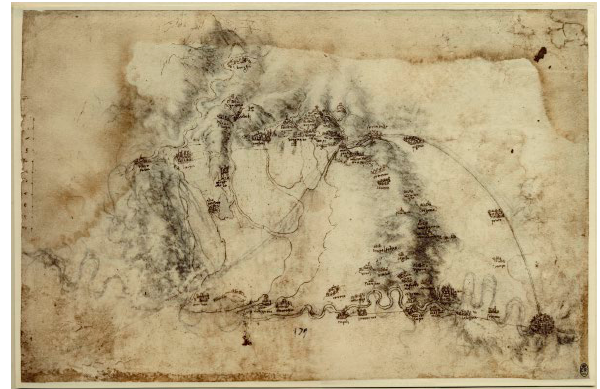
Figure 10. Map of the Lower Valdarno , Windsor, Royal Library, 12685. For Lake of Sesto to be navigable, let it [the canal] pass through Prato and Pistoia and cut Serravalle and exit into the lake. (f. 127r)